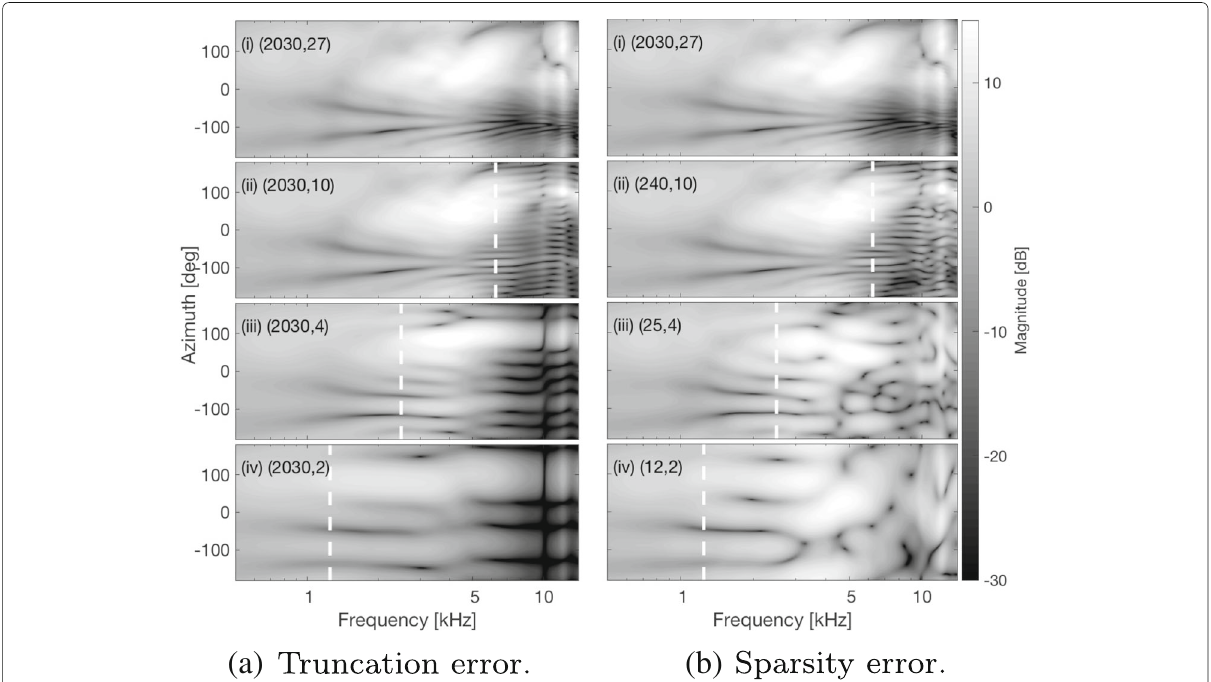
Fig. 5 Magnitude of KEMAR HRTF over the horizontal plane for different truncation (Fig. 5a) and sparsity (Fig. 5b) conditions. Each plot represents a different ( Q , (cid:11) N ) condition. The dashed white line indicates the frequency where kr = (cid:11) N , for r = 8.75cm